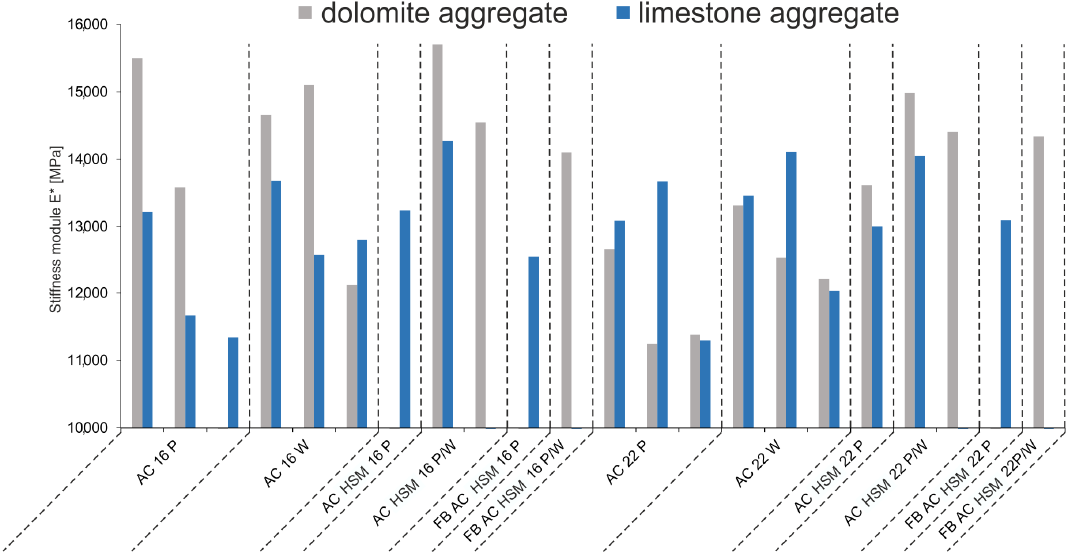
Figure 8. Values of stiffness module E* with regard to type of asphalt concrete (AC). Table 4. Stiffness module depending on the type of asphalt concrete (AC). Explanation of symbols used for mixtures: AC — asphalt concrete; AC HSM — asphalt concrete with high stiffness; FB AC HSM — asphalt concrete with high stiffness with application of foam bitumen; P — foundation layer mixture; W — binding layer mixture; P/W — foundation or binding layer mixture; 16 and 22 — upper limit of aggregate in millimeters, lower limit is 0 mm.